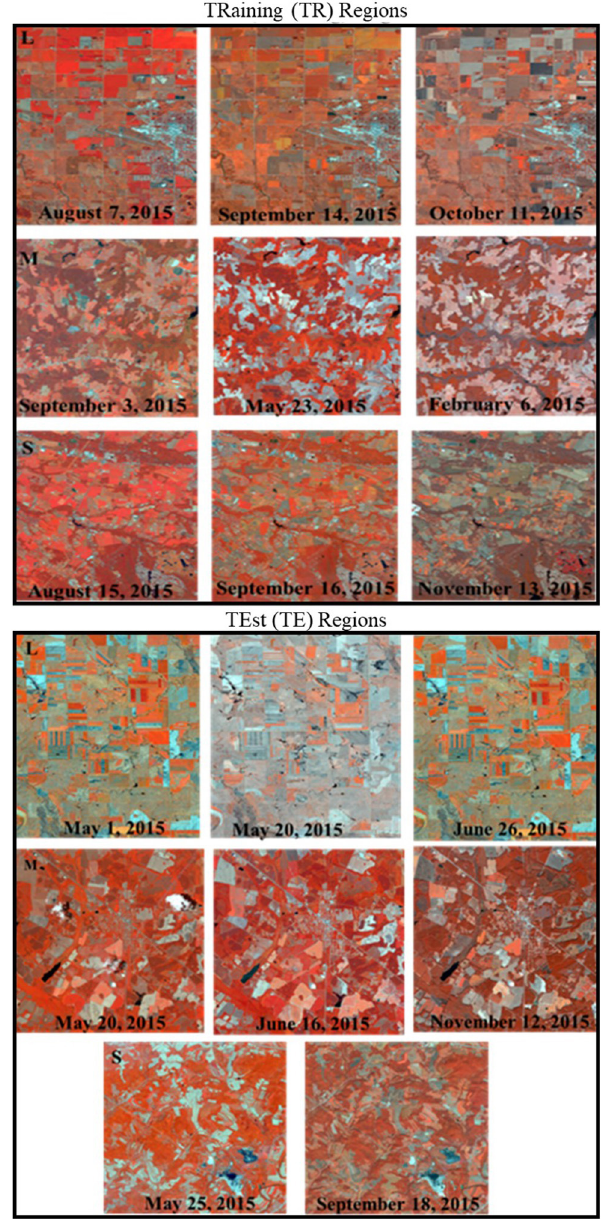
FIGURE 2 | The World View-2 images used to investigate the use of multi-dates of imagery for extending the crop type reference data from the TRaining (TR) to TEst (TE) regions in large (L), medium (M), and small (S) field sizes.